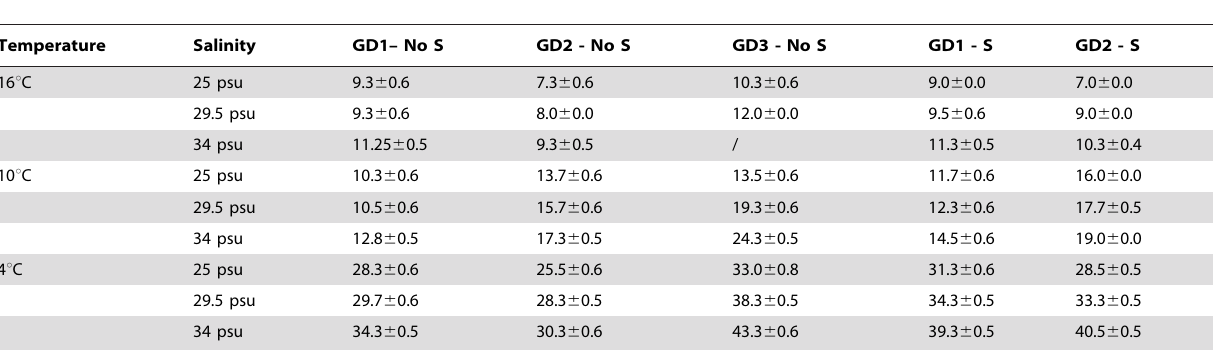
Table 3. Minimum generation time of GD1-3 under changing environmental